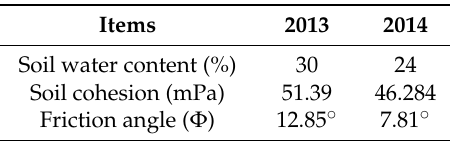
Table 4. Measurement of soil cohesion and soil friction angle before tillage at different soil water content.